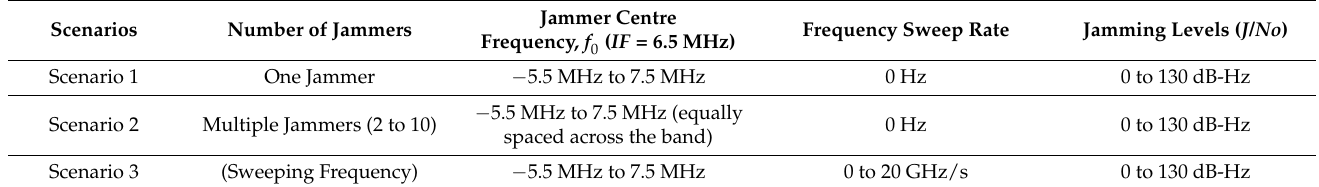
Table 1. The considered interference scenarios for evaluating the scheme.